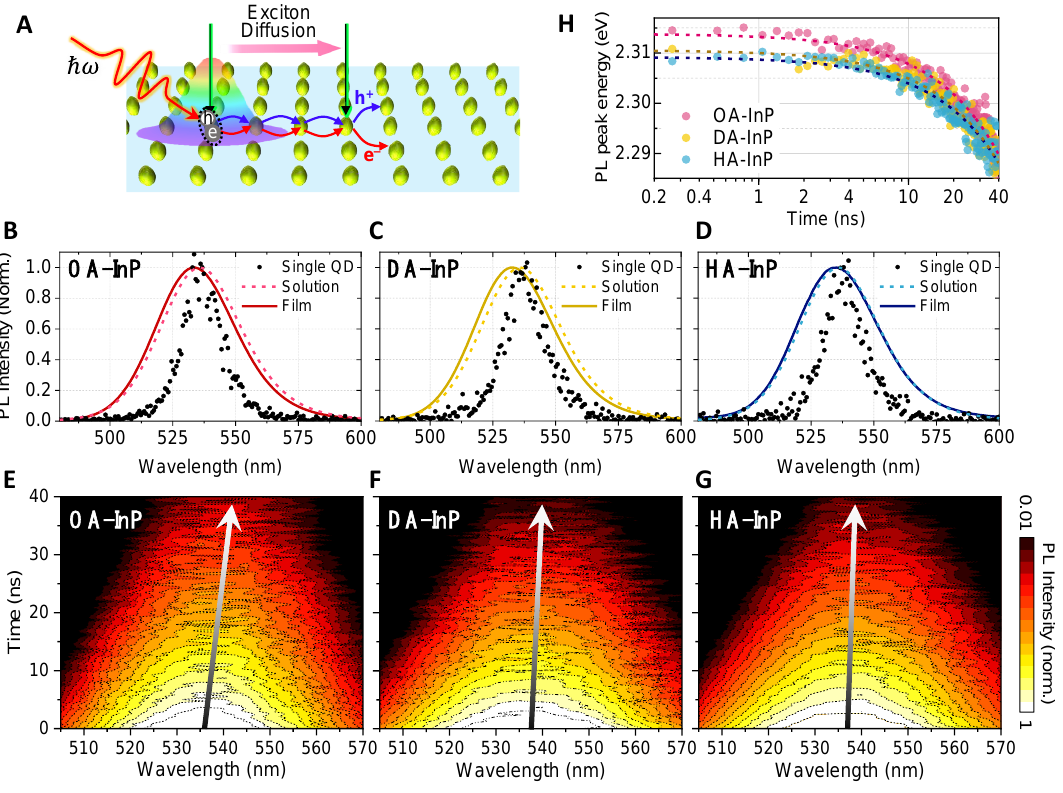
Figure 3. ( A ) A schematic diagram showing the photoinduced energy conversion in QD solids; ( B – D ) the photoluminescence (PL) spectra of the OA-InP ( B ), the DA-InP ( C ), and the HA-InP ( D ) in the form of a single QD, a QD solution, and a QD film; ( E – G ) the two-dimensional map of time- resolved photoluminescence of the OA-InP ( E ), the DA-InP ( F ), and the HA-InP ( G ) arrays; ( H ) the dynamics of emission peak shifts of the OA-InP, the DA-InP, and the HA-InP